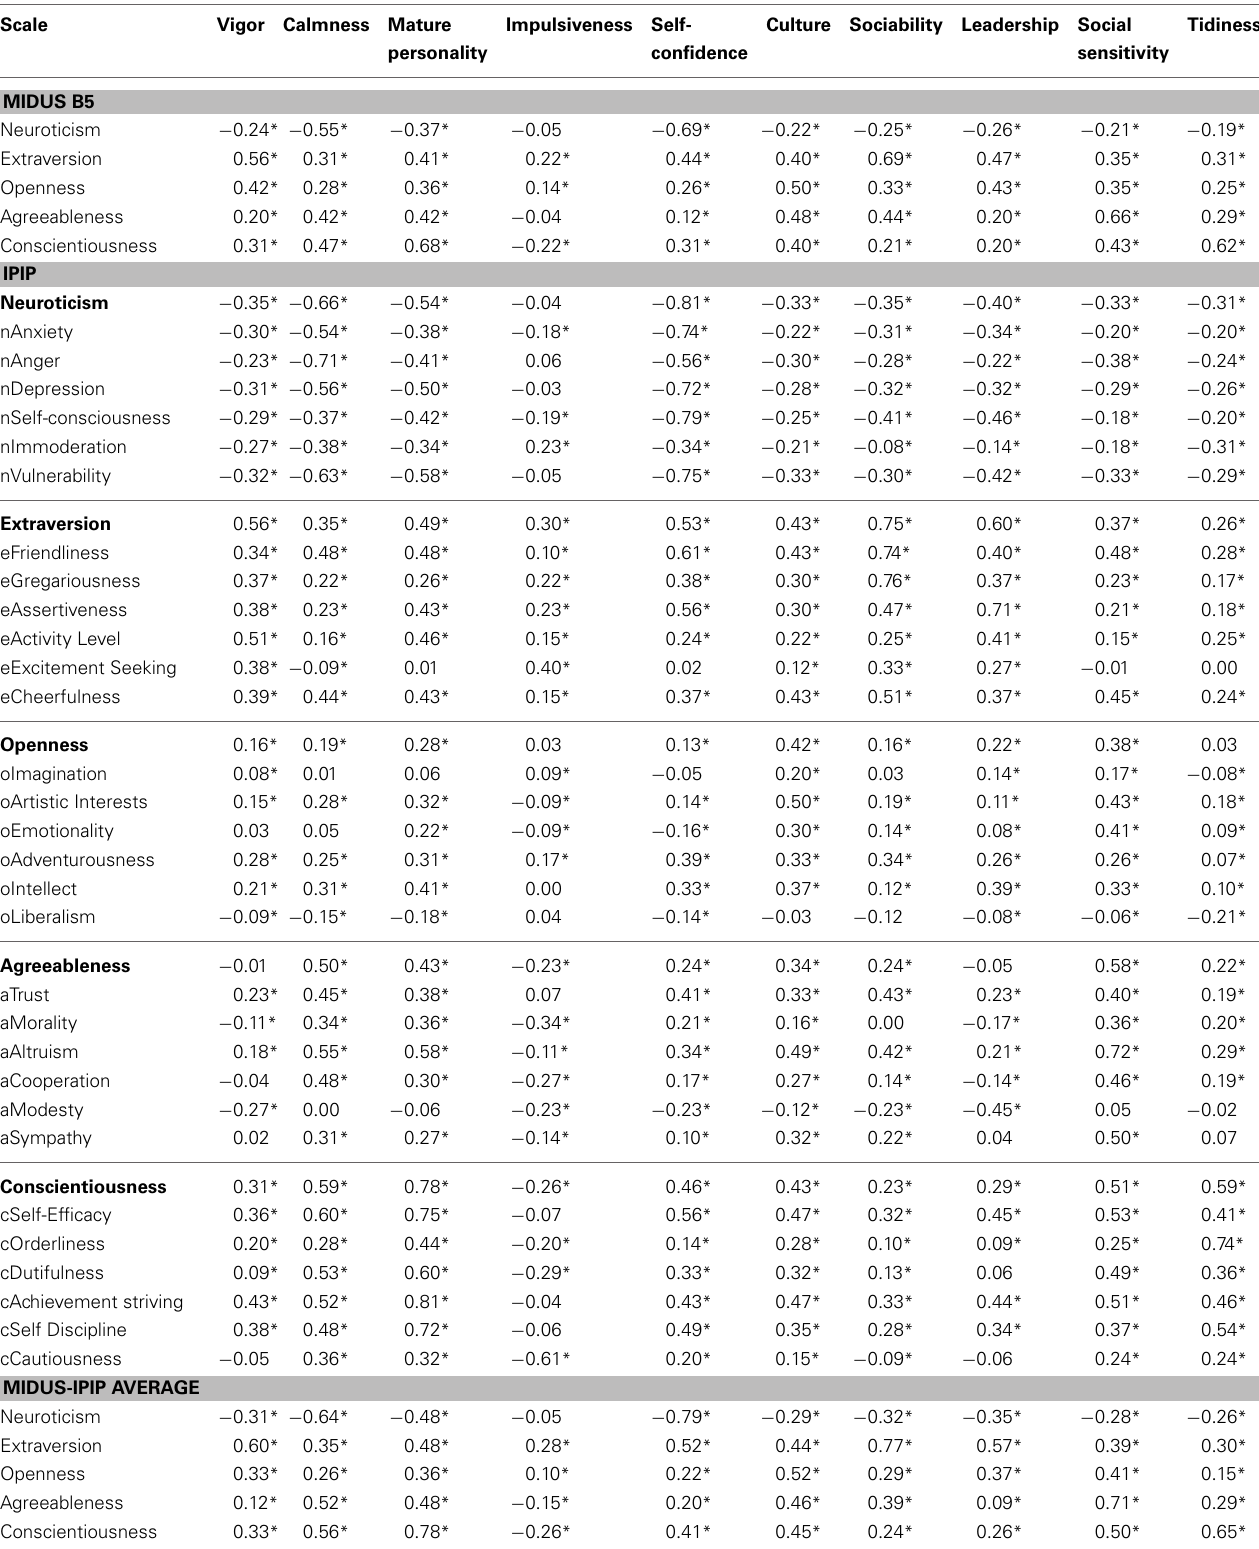
Table 4 | Correlations between the PTPI scales and Established Personality Scales.